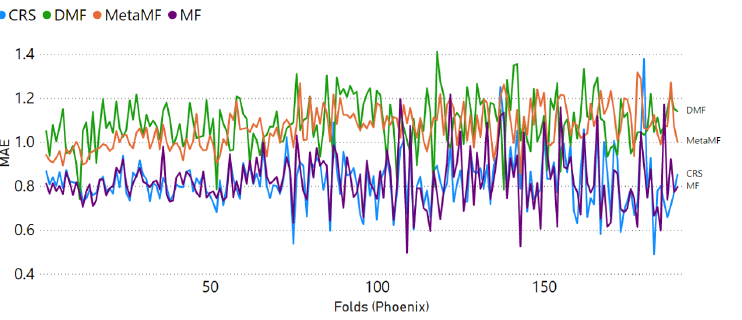
Figure 8. The MAE comparisons among the four models for each training–test dataset pair (City of Phoenix). The dataset is partitioned chronologically. (Abscissa: value of MAE; ordinate: index of